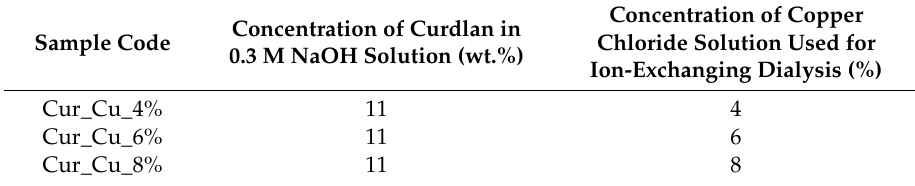
Concentration of